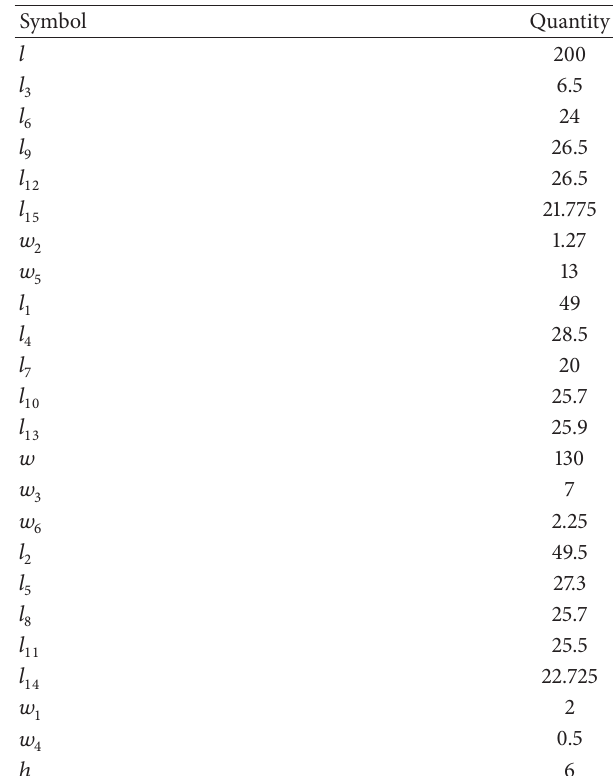
Table 1: Dimensions of the proposed antenna (unit: